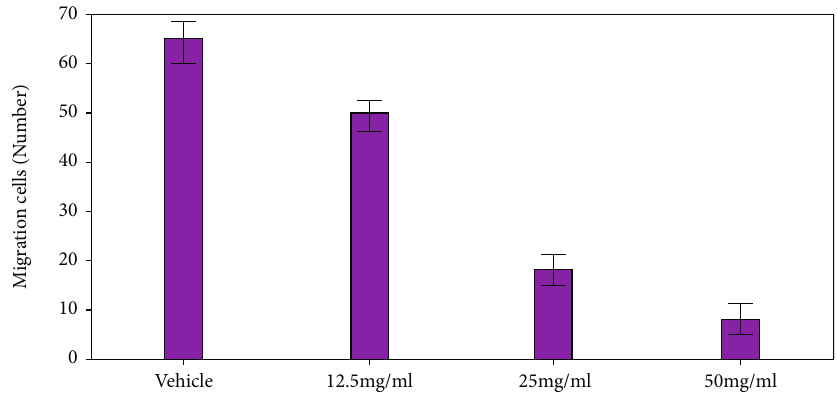
Figure 5: HQEZ reduced migration, despite the low dose that did not cause